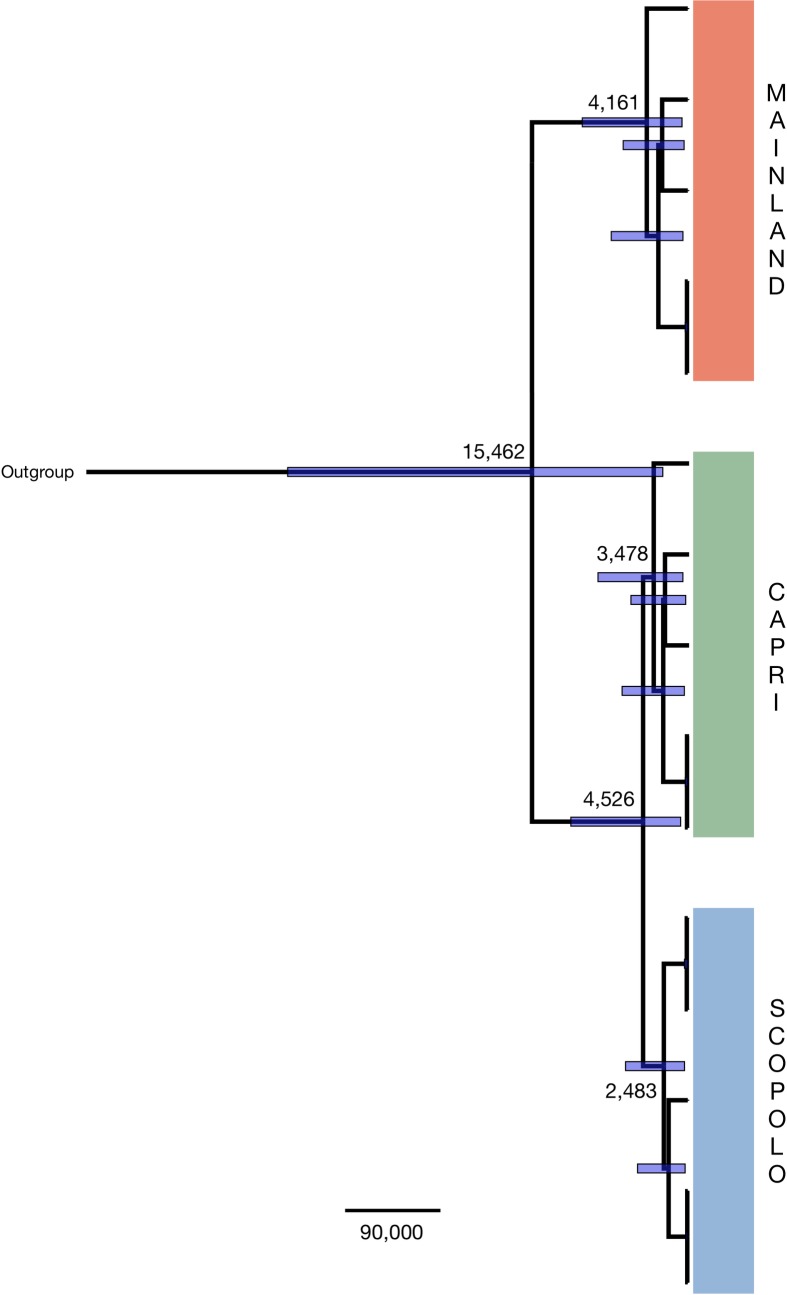
Maximum clade probability tree displayed as a chronogram from the BEAST analysis of the mtGenome alignment.All lineages evolved according to a strict clock and the HKY+G substitution model. Numbers above the nodes indicate phylogenetic support measures. Node bars illustrate the width of the 95% highest posterior density. Numbers indicate the posterior mean estimates of divergence times. On the right, colours of subclades indicate populations from mainland (orange), Capri (green) and Scopolo (azure).